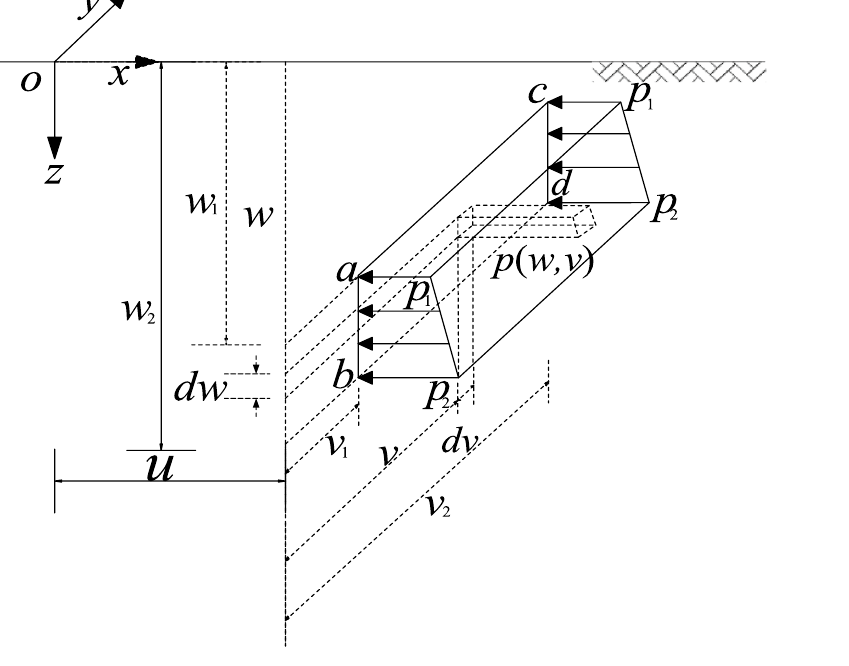
Figure 2. Horizontal pressures over a vertical